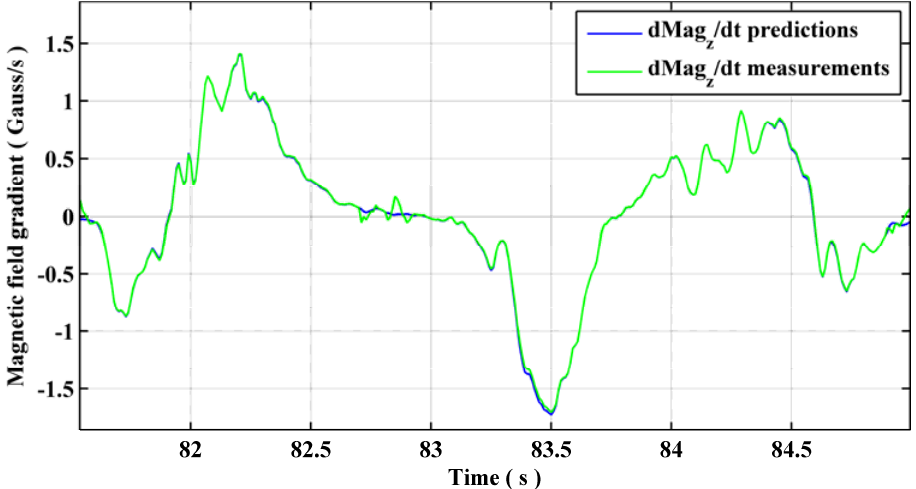
Figure 14. Estimated versus actual rate of change of magnetic field component after gyroscope bias estimation.